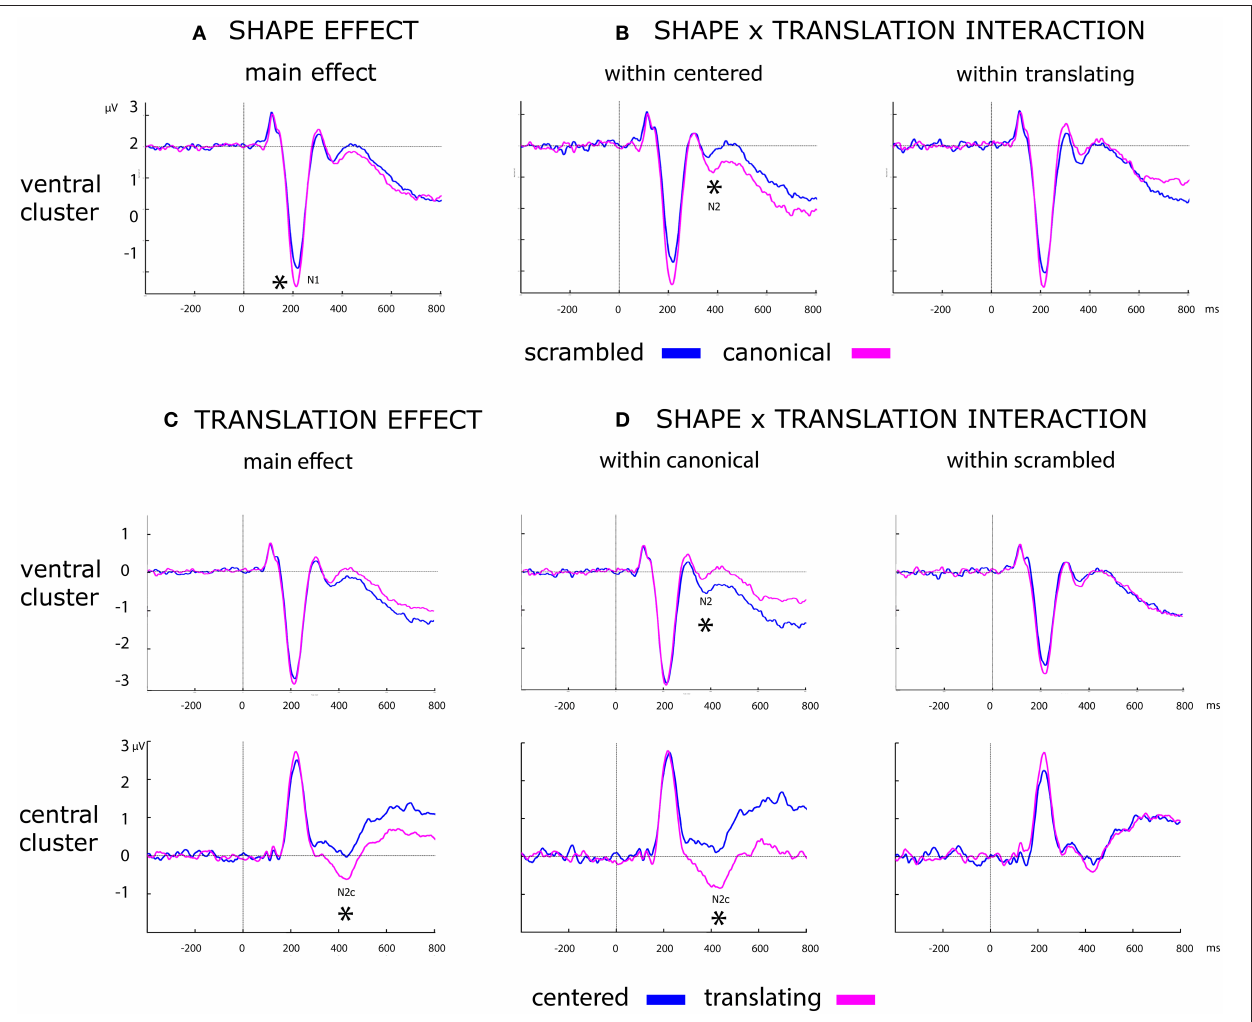
FIGURE 6 | Effect of shape, translation and their interaction over ERP data. Black asterisks below the figures represent: (A) main effect of shape during N1. (B) Post-hoc of the shape × translation interaction, showing the within centered only effect of shape during N2. (C) Main effect of translation over N2c component. (D) Post-hoc of the shape × translation interaction, showing the effect of translation during N2 and N2x only within canonical